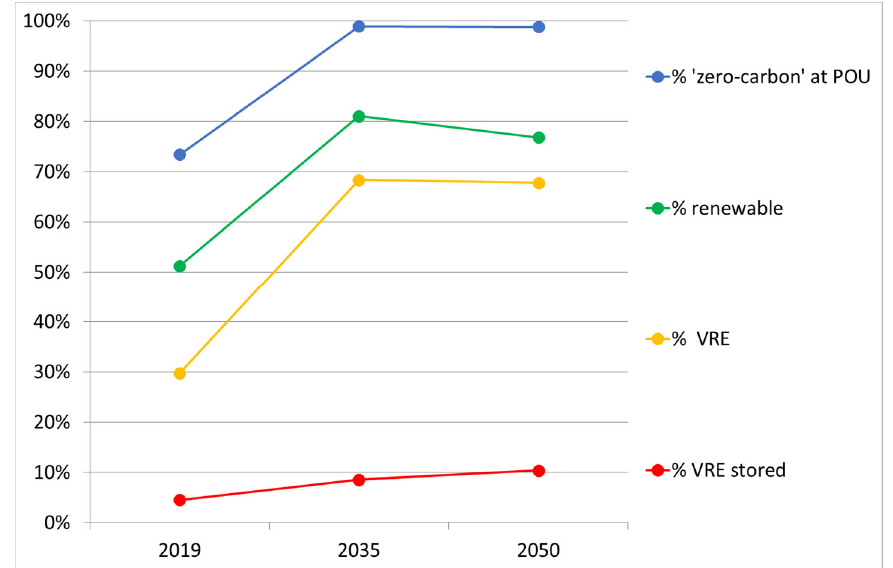
Figure 4. Expected trends (under “2 degrees” scenario assumptions) for, respectively: % of total generation that is considered “zero-carbon” at point of use (i.e., nuclear, biogas, biomass, waste, hydro, tidal, wind and solar); % of total generation that is considered “renewable” (same as above but excluding nuclear); % of total generation that is classified as “Variable Renewable Energy” (VRE; i.e., wind, solar and tidal); % of VRE generation that is sent to energy storage (as opposed to used directly).